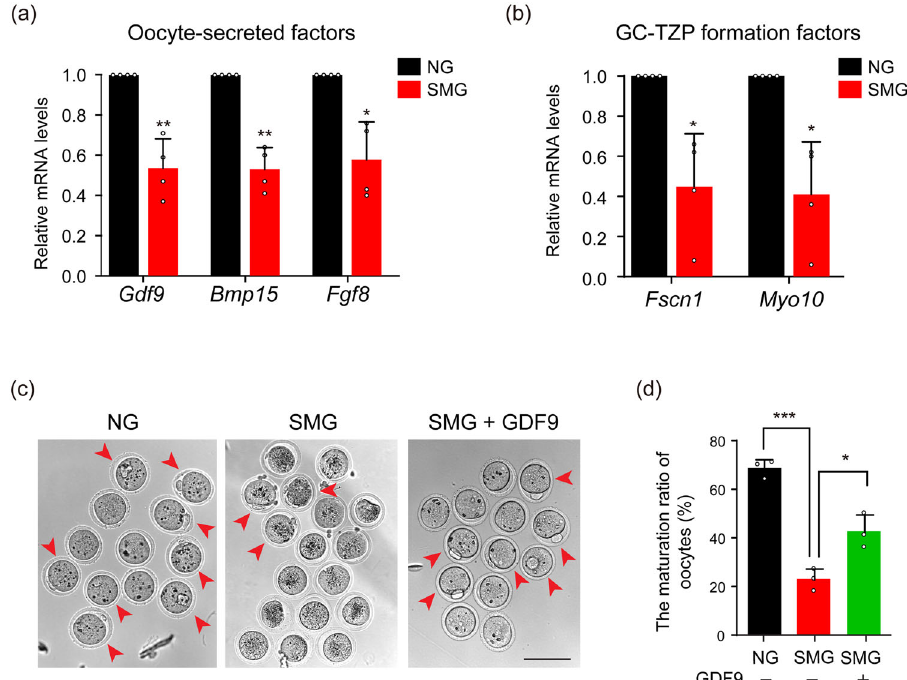
Fig. 5 Supplying OSFs rescued the damage of oocytes by SMG treatment. a Relative mRNA levels of Gdf9, Bmp15 , and Fgf8 under the SMG or the NG group, showing a decreased expression of OSFs in the SMG group ( n = 4). Gdf9: p value = 0.0081, Bmp15: p value = 0.0032, Fgf8: p value = 0.021. b Relative mRNA levels of Fscn1 and Myo10 under the SMG or the NG group, showing that the expression of GC-TZP forming related genes was downregulated after SMG treatment ( n = 4). Fscn1: p value = 0.025, Myo10: p value = 0.021. c Supplying GDF9 increased the PB1 ratio of oocytes (red arrowheads) from SMG treated follicles. Scale bars, 100 μ m. d The ratio of PB1 in different groups, showing that the GDF9 supplement signi fi cantly increased the maturation of oocytes ( n = 38 in NG, n = 35 in SMG and n = 61 in SMG + GDF9). NG v.s.